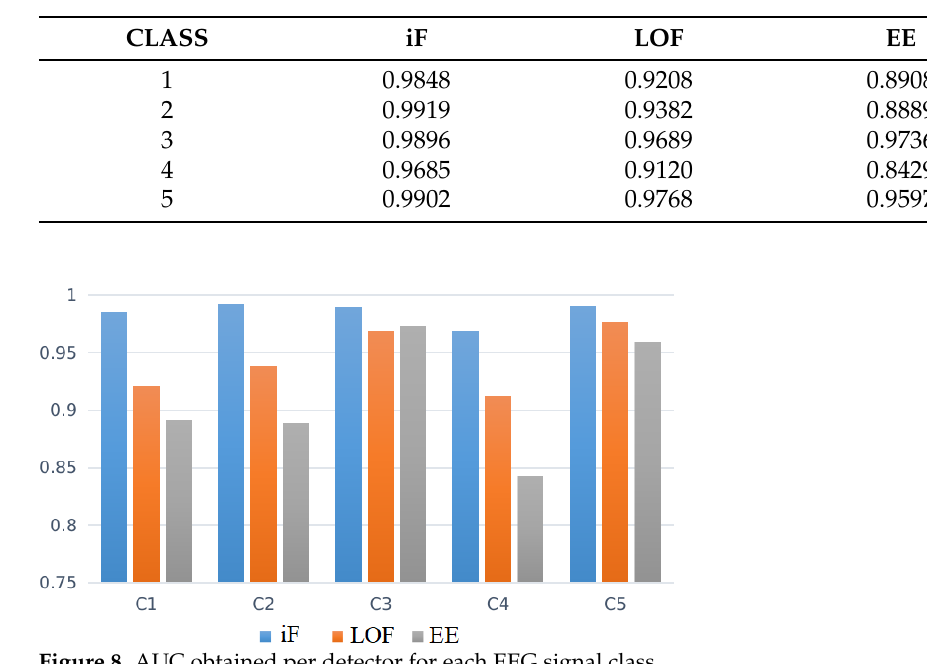
Table 4. Overall detection results of all anomaly detection methods.